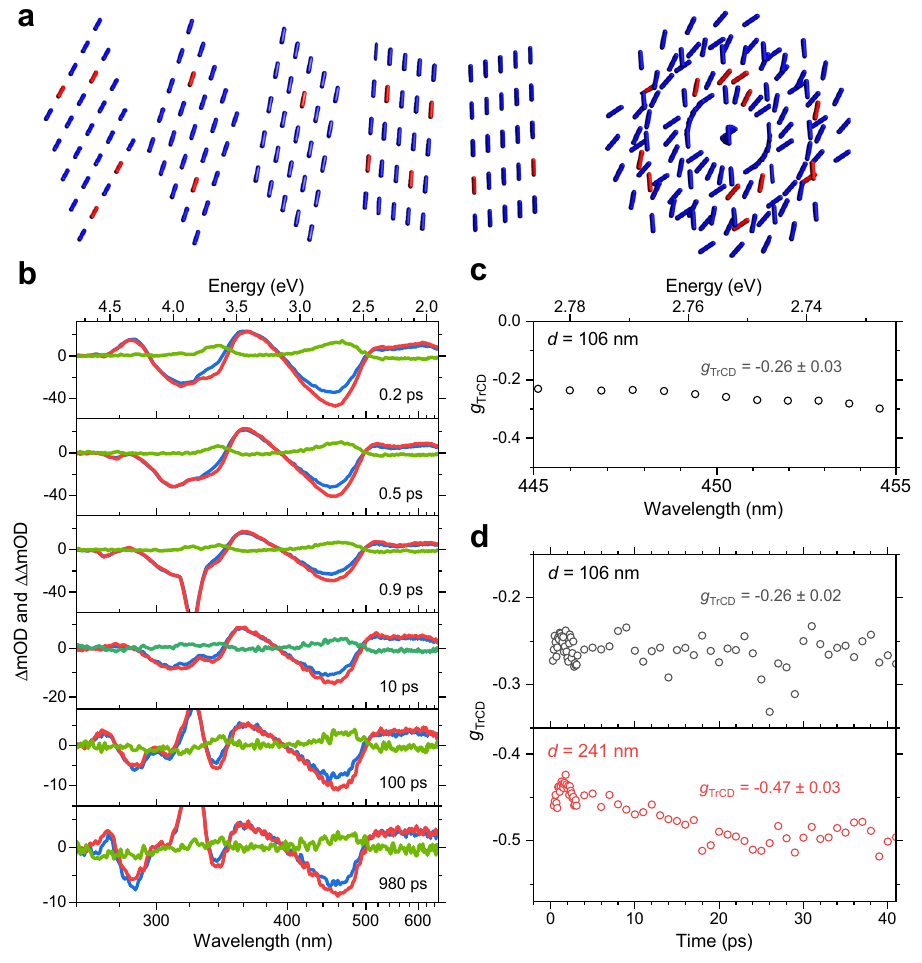
Fig. 5 Supramolecular origin of the ultrafast TrCD response of c-PFBT thin fi lms. a Schematic representation of a cholesteric helical arrangement consisting of fi ve layers with 25 c-PFBT units, where ground state c-PFBT units are shown as blue cylinders and excited state c-PFBT units are represented by red cylinders; left side: side view, right side: view along the twist axis. b Transient spectra for a 106 nm thin c-PFBT fi lm at six different delay times: transient absorption for probing with left-circularly polarised light (blue), right-circularly polarised light (red) and the resulting TrCD spectrum (green). Note the about 50% smaller TrCD response compared with the 241 nm thin fi lm (Fig. 4a) despite the comparable amplitude of the transient absorption signals. c Wavelength-dependence of the dissymmetry factor g TrCD . d Time-dependence of the dissymmetry factor g TrCD for a 106 nm thin fi lm (top) and a 241 nm thin fi lm